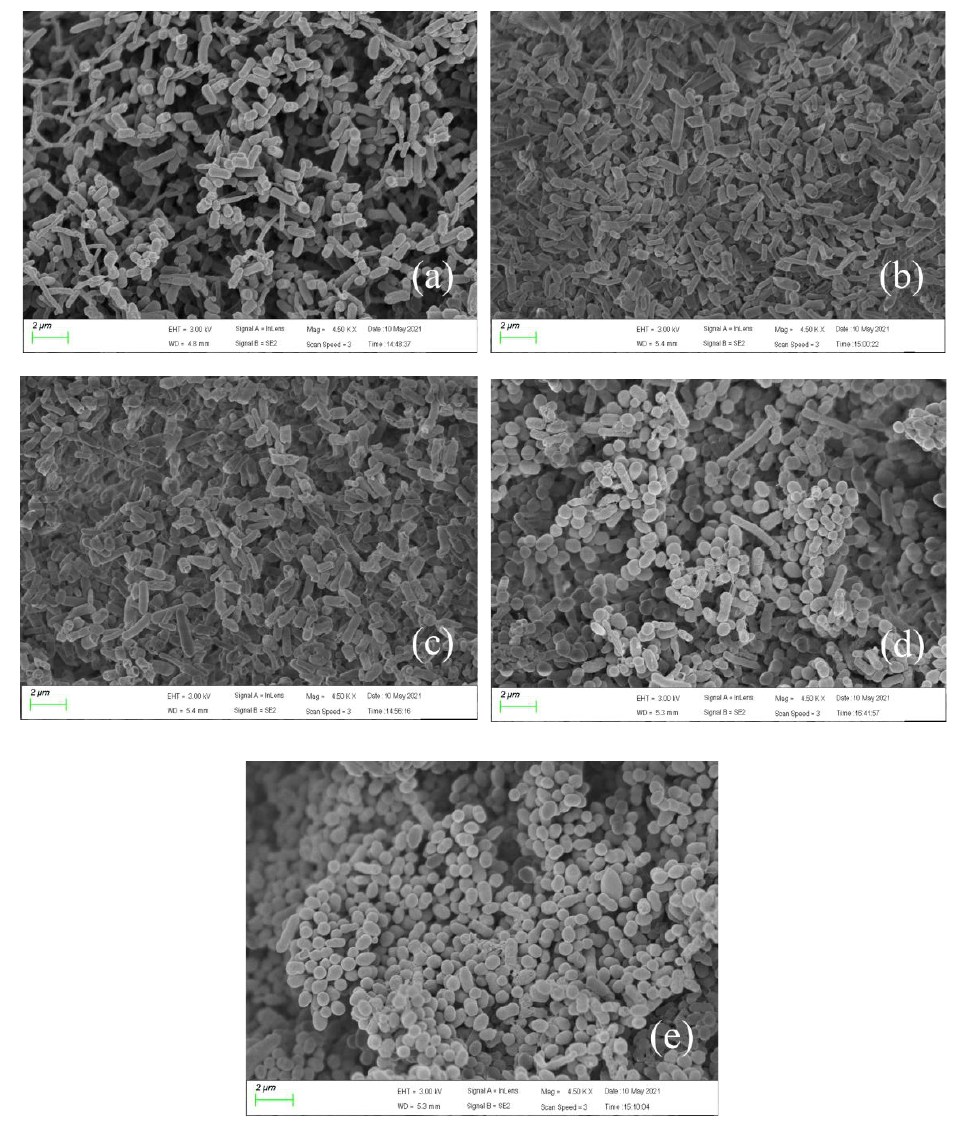
Figure 5. SEM images of E. coli strain 2 under different pressures: ( a ) 0 MPa, ( b ) 0.1 MPa, ( c ) 0.15 MPa, ( d ) 0.2 MPa, and ( e ) 0.3 MPa (the magnification is 4500×; the scale bar = 2 μm). SEM, scanning electron microscopy.